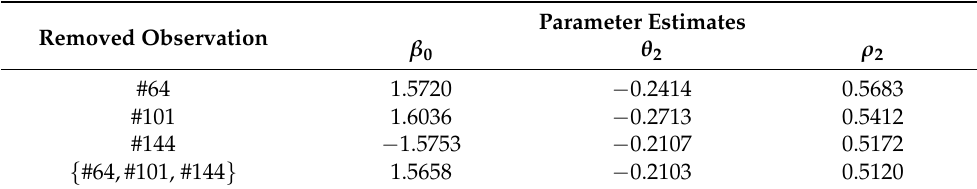
Table 8. Maximum likelihood estimates (all the p -values are <0.001) for parameters β 0 , θ 2 , and ρ 2 of the Weibull regression model after removing the